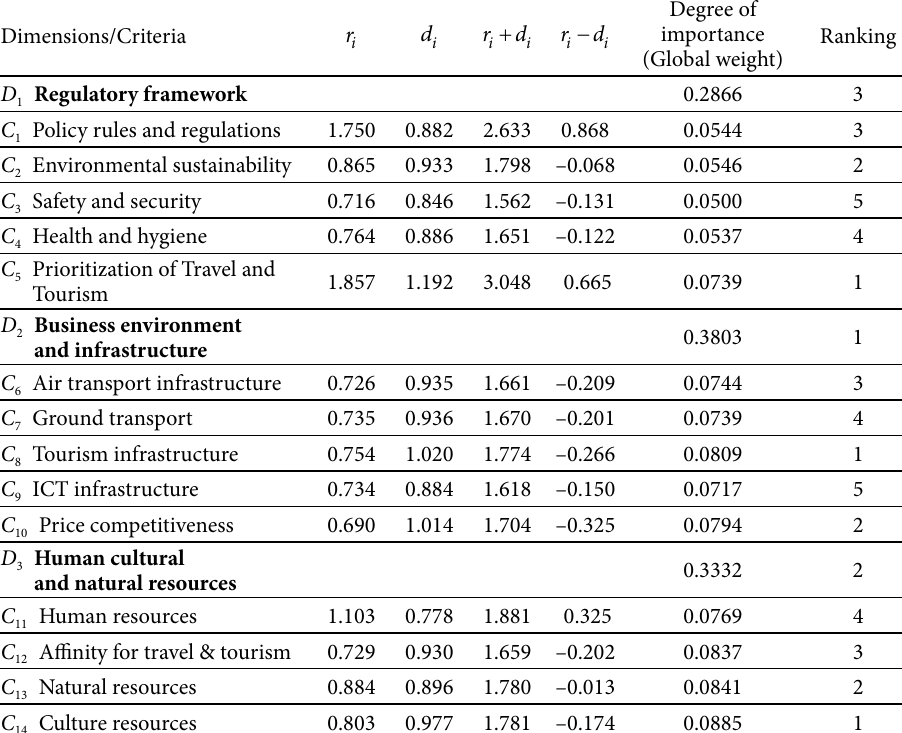
Table 2. The sum of influences, weights and rankings of each criterion